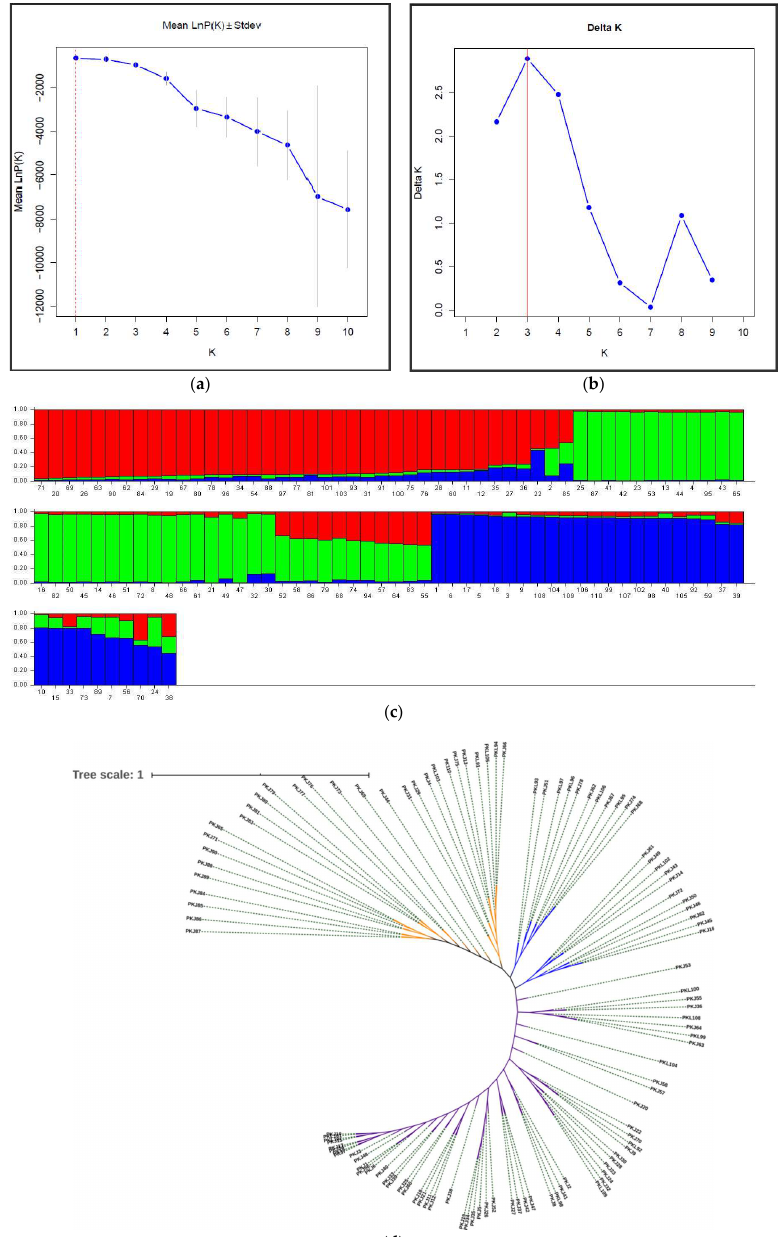
Figure 3. Genetic structural and cluster analyses of 110 P. koraiensis clones. ( a ) The probability of the data ln P(D) (+SD) against the number of K clusters; ( b ) ΔK values from the mean log-likelihood probabilities inferred clusters (K); ( c ) Estimated genetic clustering (k = 3) and ( d ) showed clusters based on Nei’s genetic distance. The x -axis in ( c ) indicates the clone’s number, and the y -axis value shows group membership.